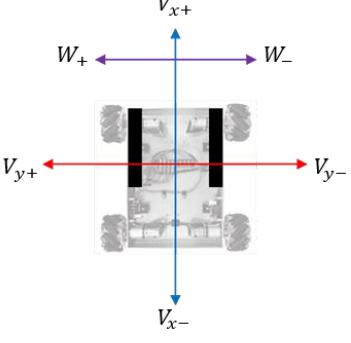
Figure 12. Control factors of the mobile robot.